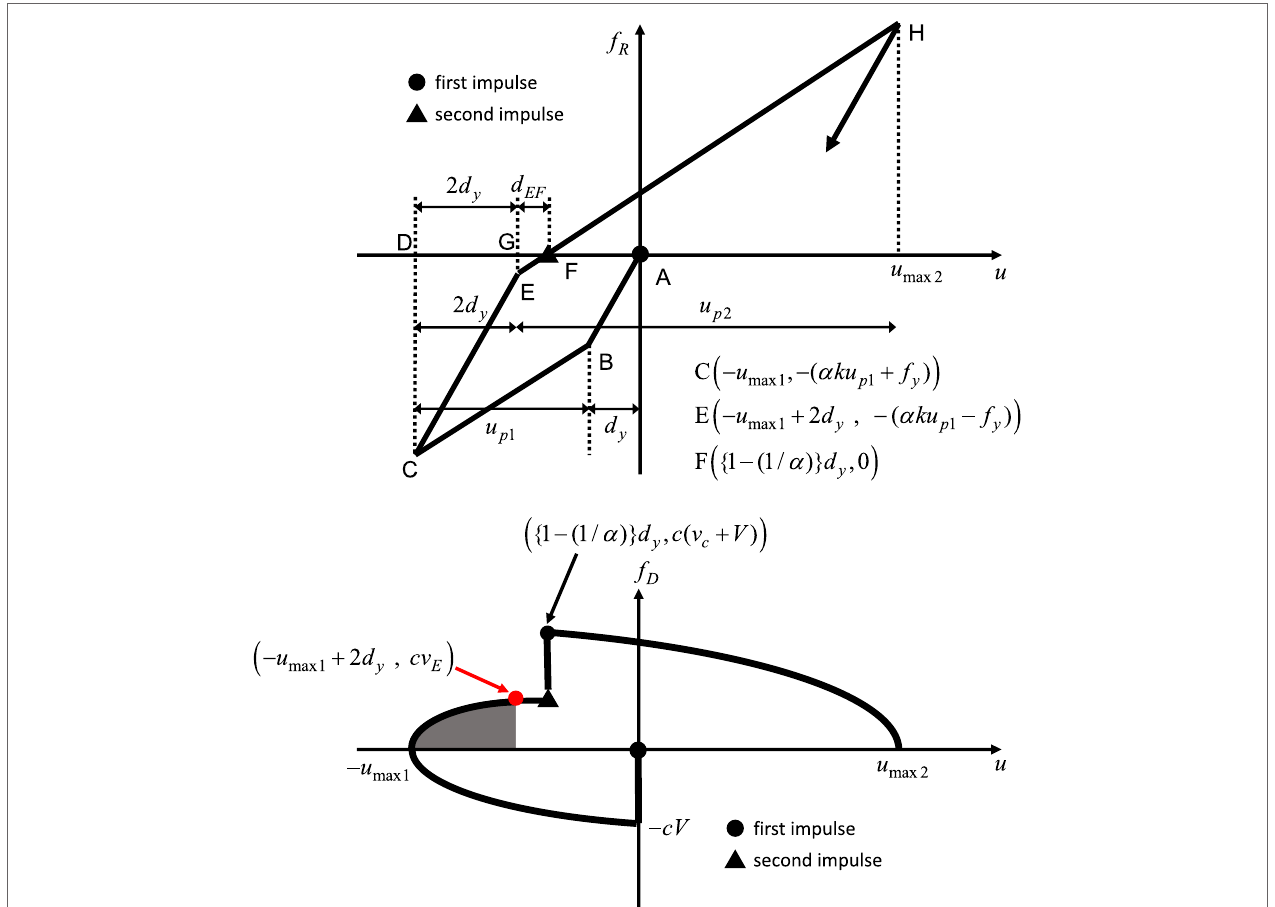
FIGURE 7 | Evaluation of maximum elastic–plastic deformation under critical double impulse based on energy balance and quadratic function approximation of damping force–deformation relation for CASE 3-2 [( V / V y ) CASE3 (cid:20) V / V y